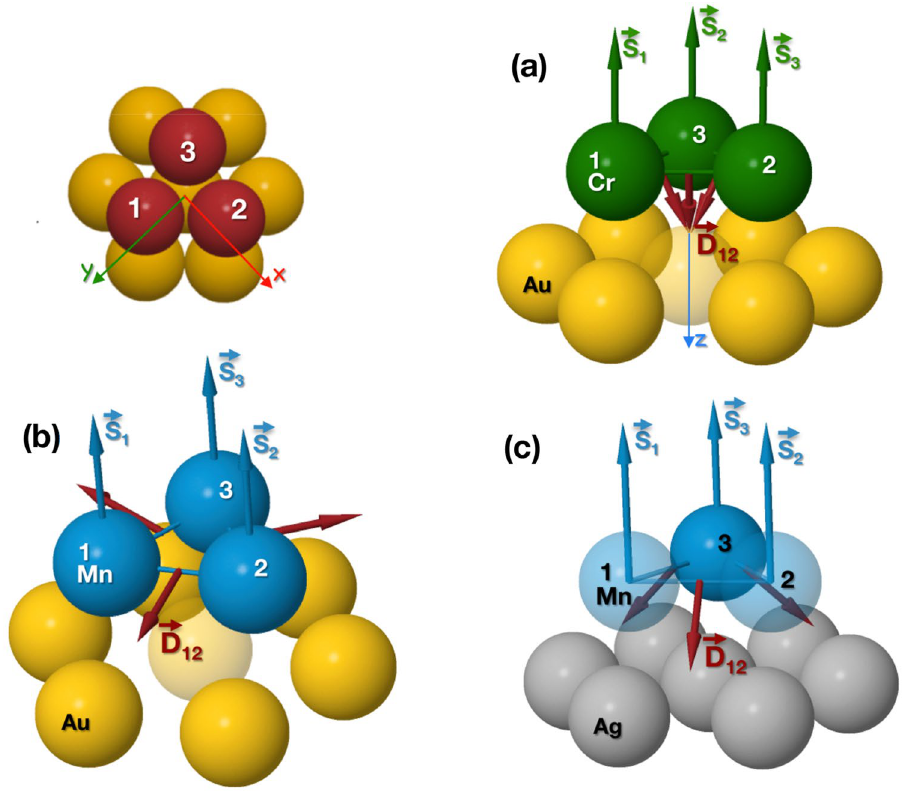
Figure 1. Schematic representation of a triangular trimer on an fcc substrate (top left) and the adopted coordinate system. In (a) the moments and DMI vectors of Cr on Au(111) are shown. In (b) results for Mn on fcc Au(111) are displayed, and in (c) results for Mn on fcc Ag(111) is shown. The dark red arrows denote the DMI direction ( D ij ), calculated for a collinear magnetic configuration (ferromagnetic with the magnetic z ). moments ( S 1 , S 2 , S 3 ) perpendicular to the surface along −ˆ